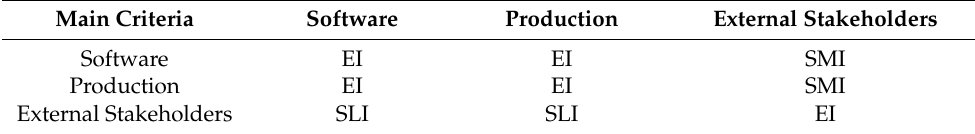
Table 4. Linguistic pairwise comparison